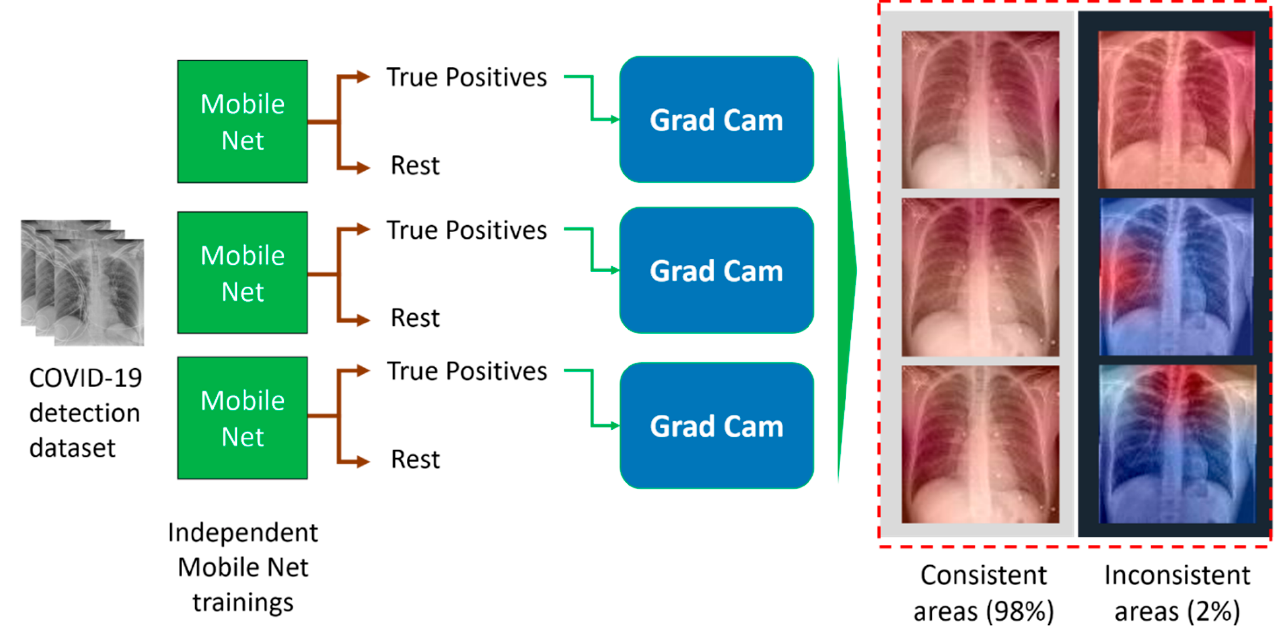
Figure 7. Reproducibility of test methodology.